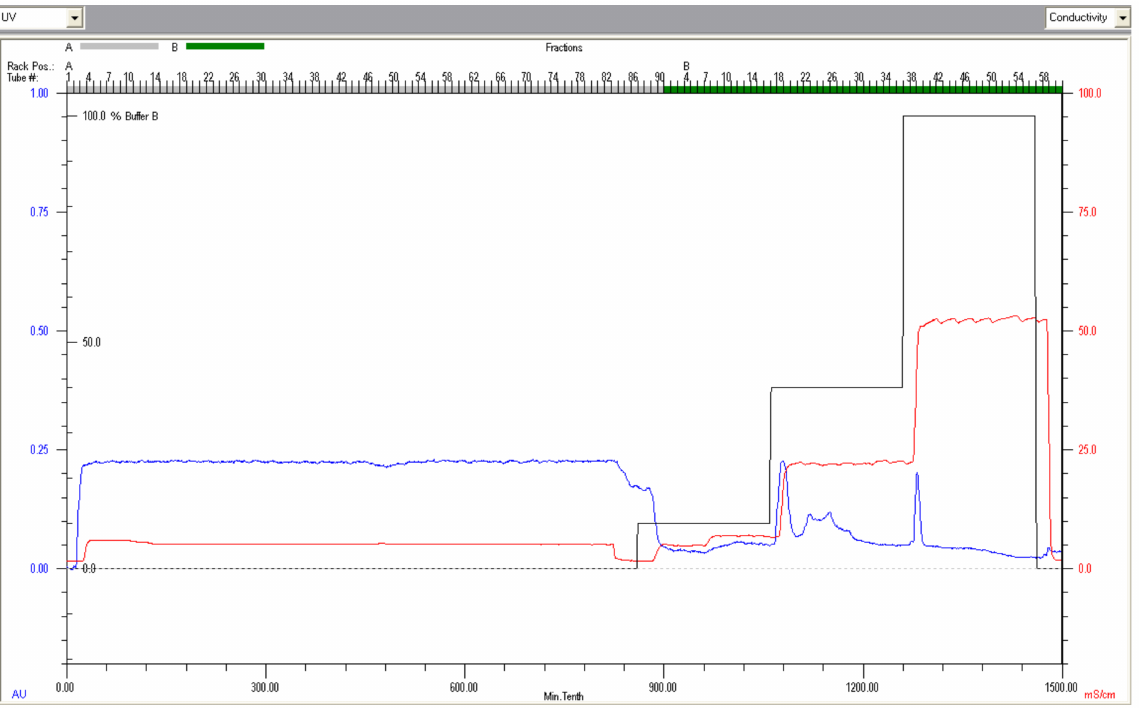
Figure 1. Fractionation of lactoferrin (Lf) from deer milk using cation exchange fast protein liquid chromatography